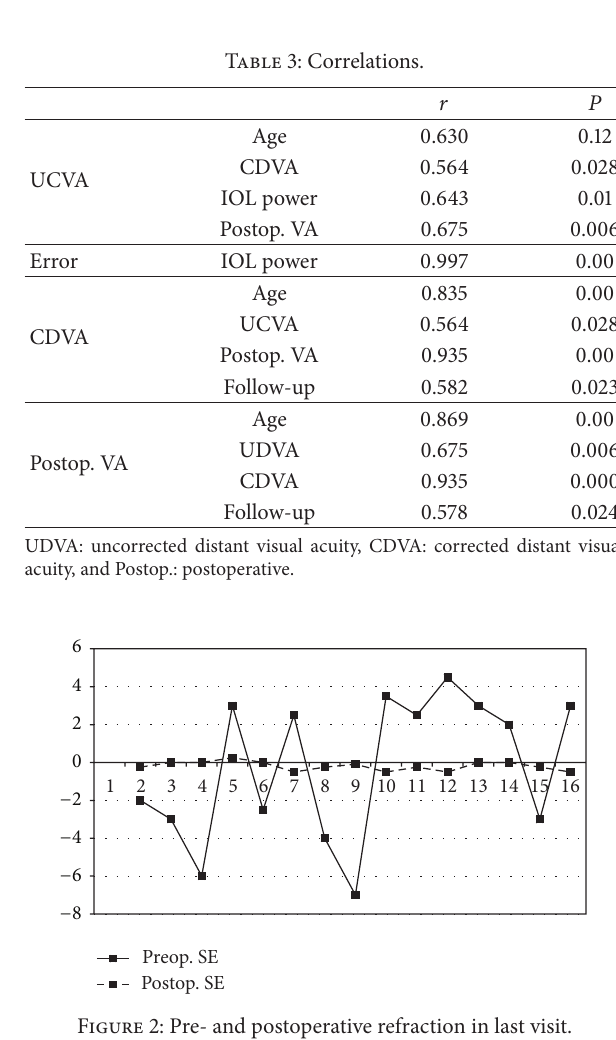
Figure 2: Pre- and postoperative refraction in last